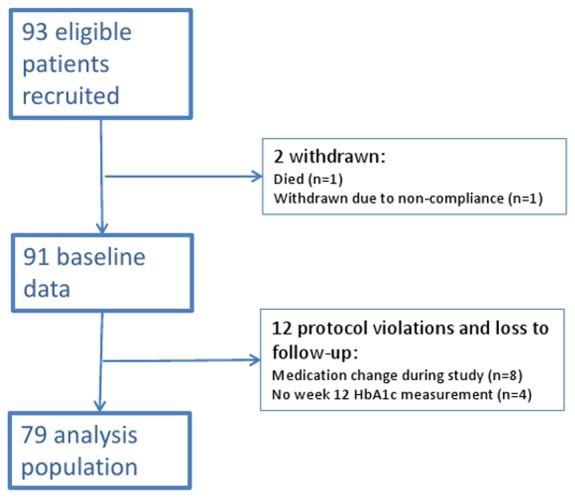
Study flow chart.